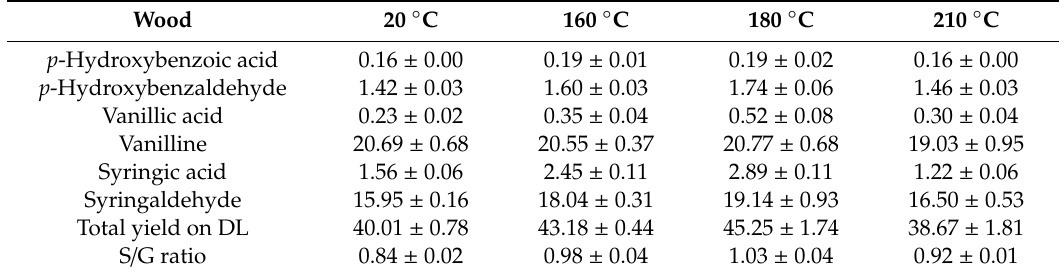
Table 3. Nitrobenzene oxidation products of iroko dioxane lignins (mean ± SD, %). Wood